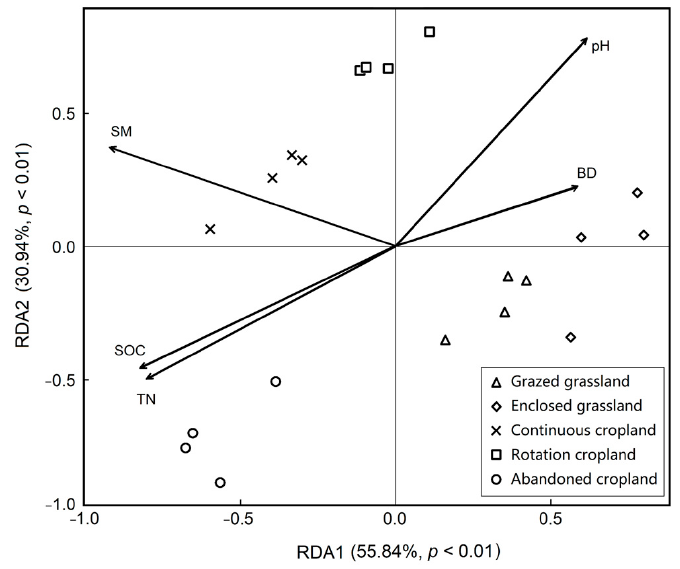
Figure 6. Redundancy analysis (RDA) of the soil bacterial and edaphic factors under the five land use patterns. SM means soil moisture, BD means bulk density, SOC means soil organic carbon and TN means total nitrogen.